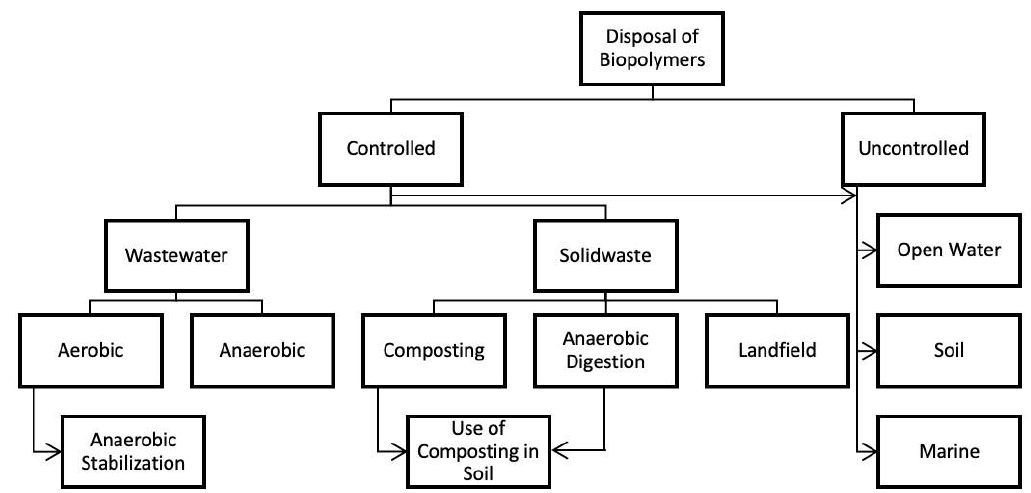
Figure 14. Waste management process of biopolymers. Adapted from “Bioplastics: A boon or bane?” Renewable and Sustainable Energy Reviews, vol. 147. Elsevier Ltd ., Sep. 01, 2021. doi: 10.1016/j.rser.2021.111237 [31].